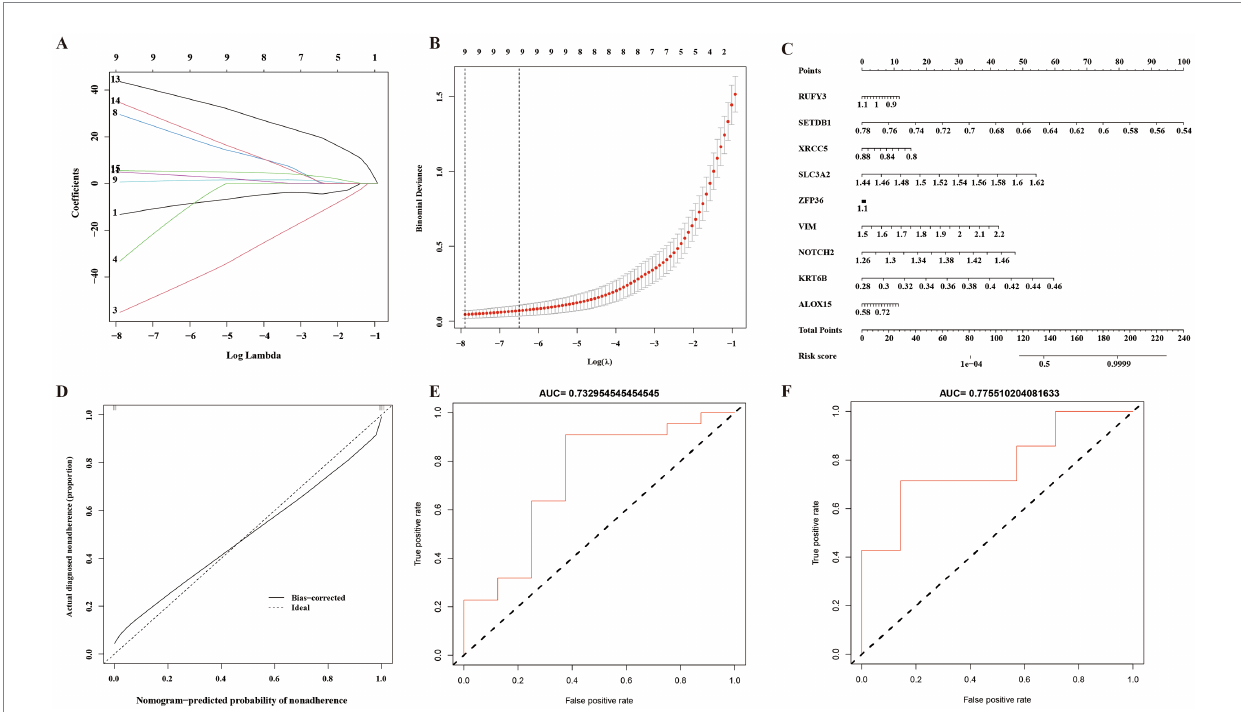
FIGURE 6 A prognostic model of Alzheimer’s disease based on ferroptosis. (A) 10-fold cross-validation for tuning parameter selection in a LASSO Cox regression model. (B) Coefficient distribution trend of LASSO Cox regression. (C) Density plots of total points and representative genes show their distribution. (D) The importance of representative gene features based on random forest algorithm and the ideal number of gene features. (E) Control group and Cluster 1 group ROC curve analysis of prognostic risk model. AUC: Area under the time-dependent receiver operating characteristic curve. (F) Cluster 1 group and Cluster 2 group ROC curve analysis of prognostic risk model. AUC: Area under the time-dependent receiver operating characteristic curve.